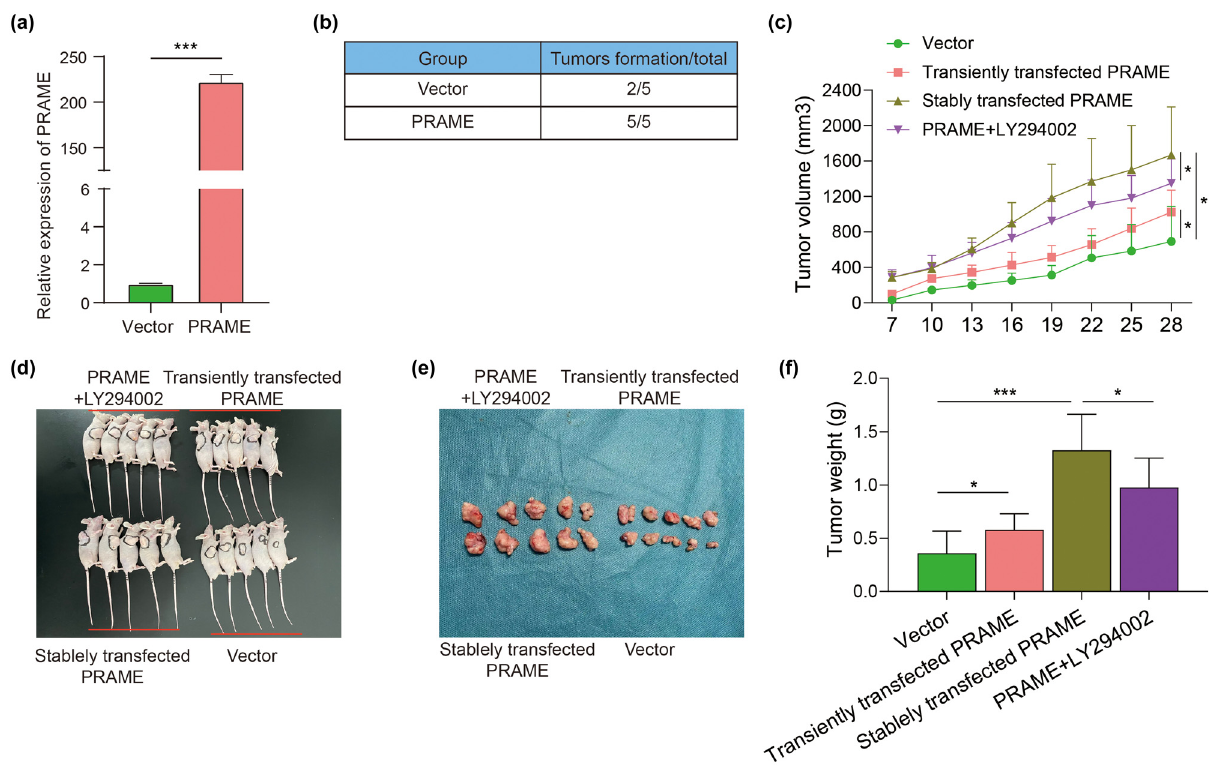
Figure 6: PRAME promotes the proliferation of LSCC in vivo . ( a ) The expression levels of overexpressed PRAME were signi fi cantly higher in AMC - HN - 8 by means of qRT - PCR. ( b ) All of fi ve athymic Nu/Nu mice were inoculated by the AMC - HN - 8 cells transiently transfected with overexpressed PRAME grew tumors, while only two mice in the empty vector group formed any palpable tumors after one week. ( c ) Tumor growth rate was evidently increased in the stably transfected PRAME group relative to the empty vector group, and tumors ’ growth rate with LY294002 was decreased compared with the stably transfected PRAME group. ( d ) The fi gure of tumor dimensions in nude mice at the end of the experiment. ( e and f ) The size and weight of the tumors in the stably transfected PRAME group were signi fi cantly increased relative to the empty vector group, while the size and weight of the tumors with LY294002 were decreased ( * P < 0.05, ** P < 0.01, *** P < 0.001 )